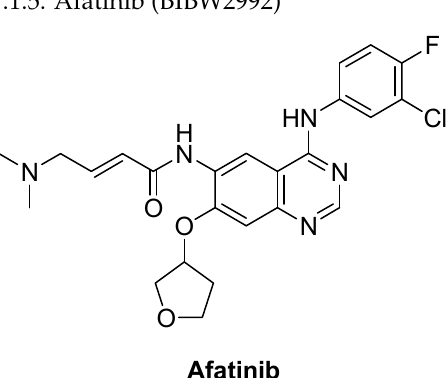
Figure 4. Best-docked pose of Lapatinib within the HER4 (ErbB4) active site, where hydrogen bond interactions are shown as green dashed lines ( left panel ) and its corresponding detailed 2D-interactions map ( right panel ). This docking study was conducted by us, no copyright